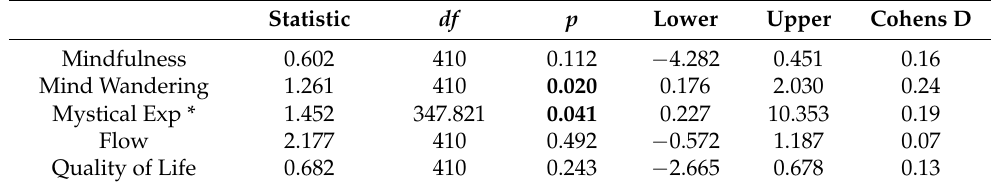
Table 2. Results of T -Tests Showing Differences Between Call and Response vs. Repetitive